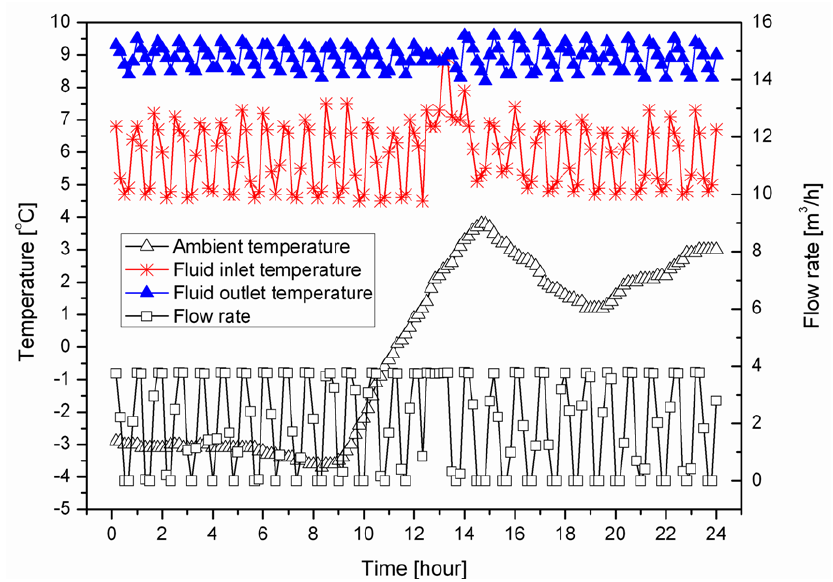
Figure 8. Recording of the GSHP system operation in a typical winter day (December 27,